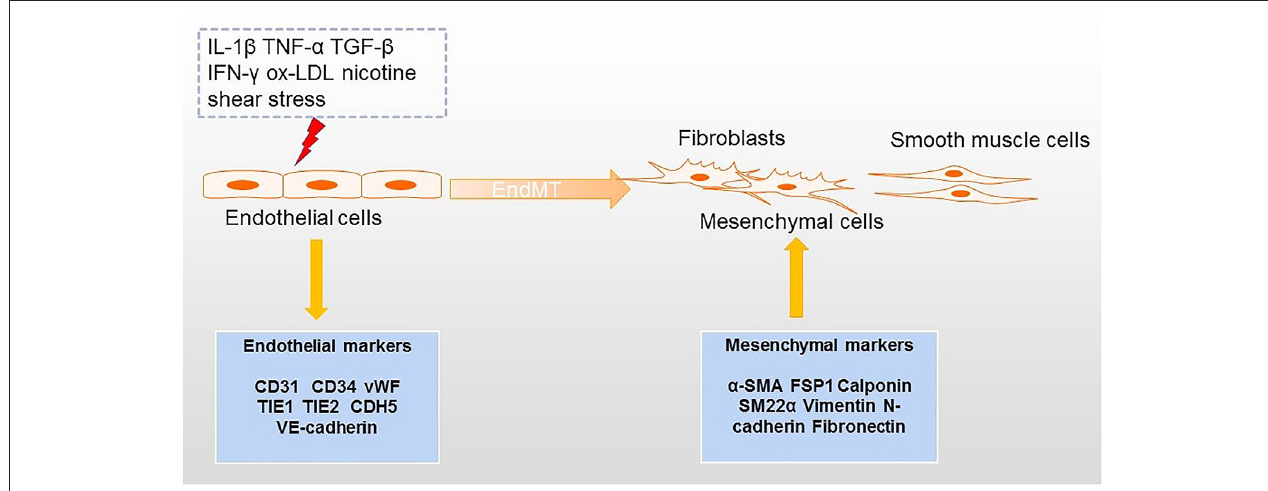
FIGURE 1 | Processes inducing EndMT in atherosclerosis. Factors that can lead to EndMT include several inflammatory cytokines, ox-LDL, nicotine, and shear stress. The transition from endothelial cells to mesenchymal cells (e.g., fibroblasts and smooth muscle cells) is accompanied by downregulation of endothelial markers and upregulation of mesenchymal